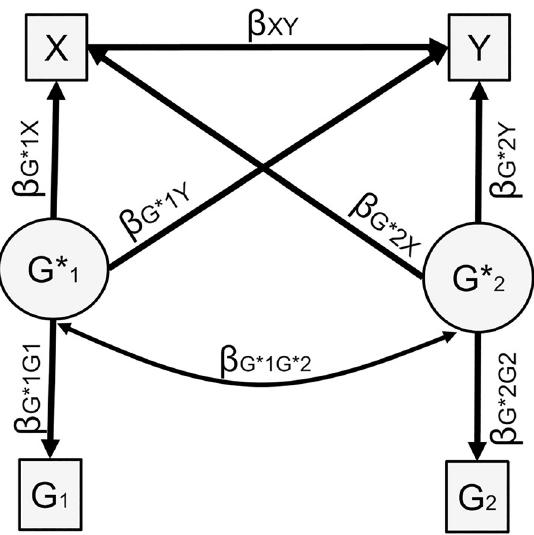
Fig 7. Sensitivity analysis, two polygenic scores. The following constraints are imposed on the model: b